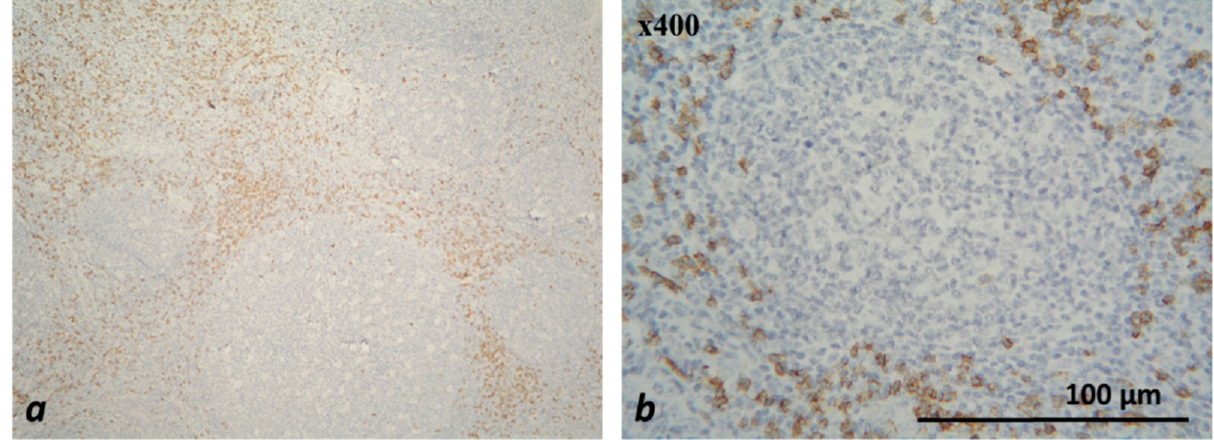
Figure 1. Microscopic evaluation of IHC-stained CD8+ T-lymphocyte subtypes (colored brownish) in tonsil—×200 ( a ), ×400 ( b ).